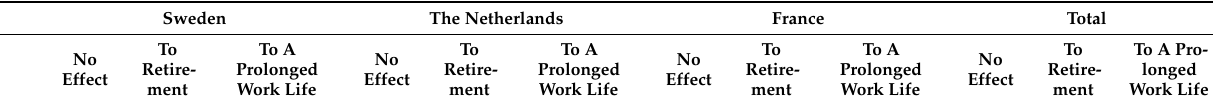
Table 5. Result of the survey; percentages of respondents considering the aspects as either contributing to retirement or to a prolonged work life, or as having no effect on the decision. Percentages is presented within each country and in